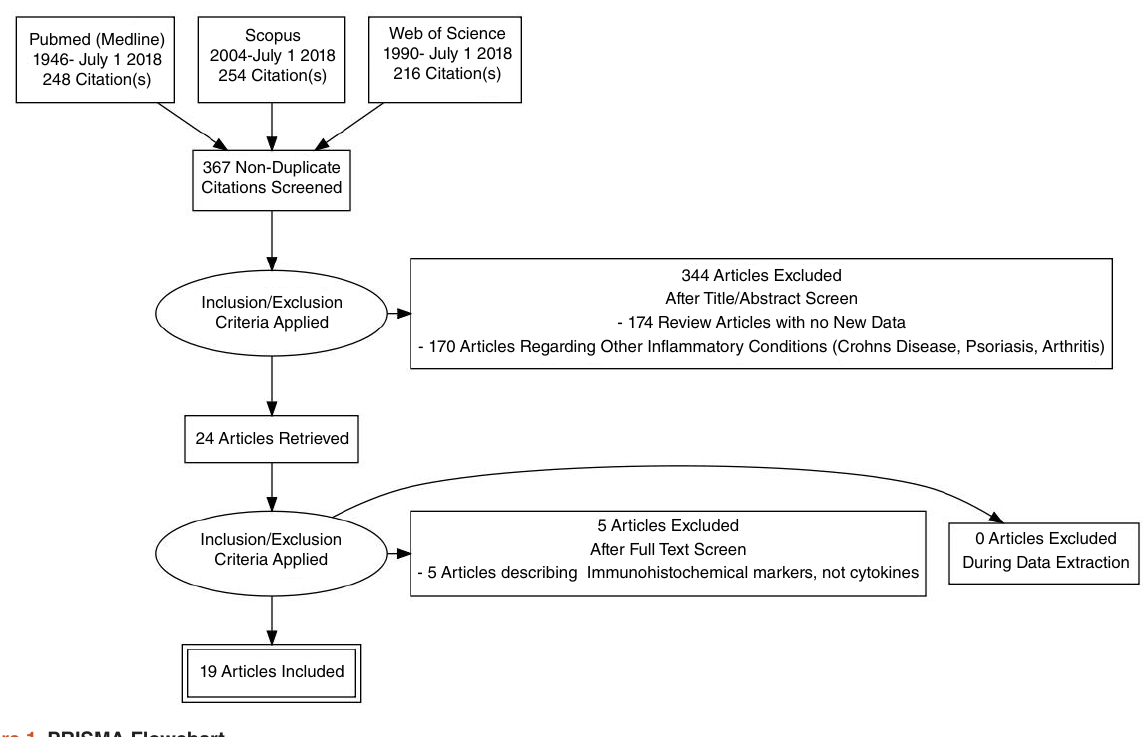
Figure 1. PRISMA